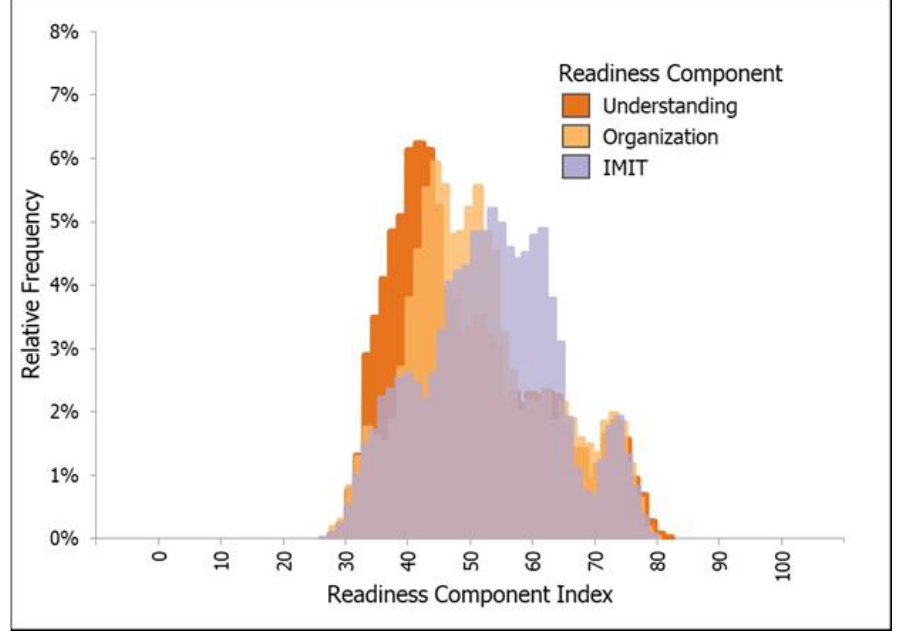
Figure 3. Collective Readiness Component Index, a histogram of the Agency Readiness Component Indices.